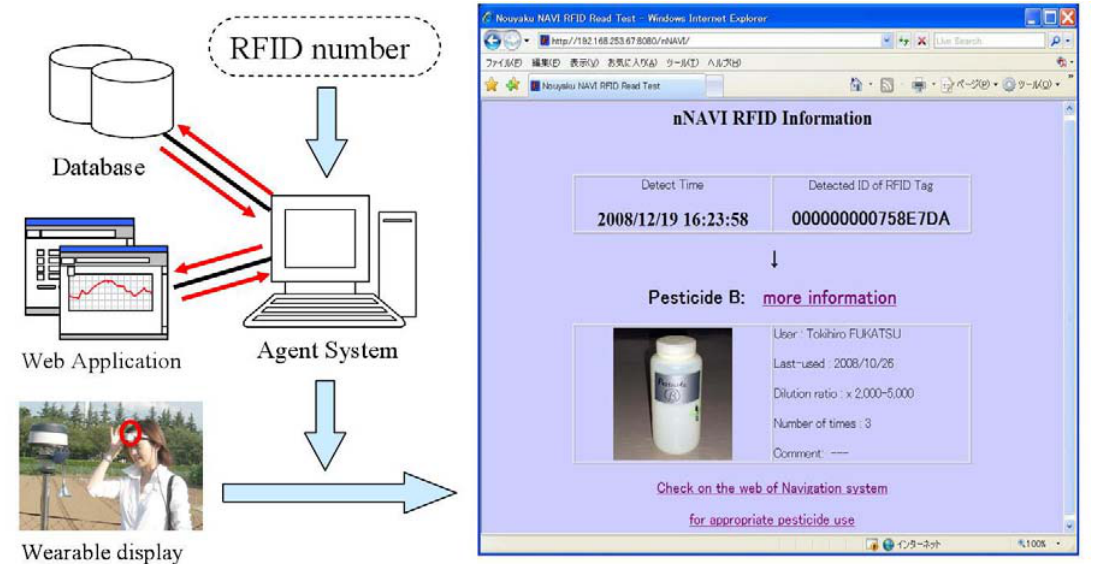
Figure 10. Support application of providing useful